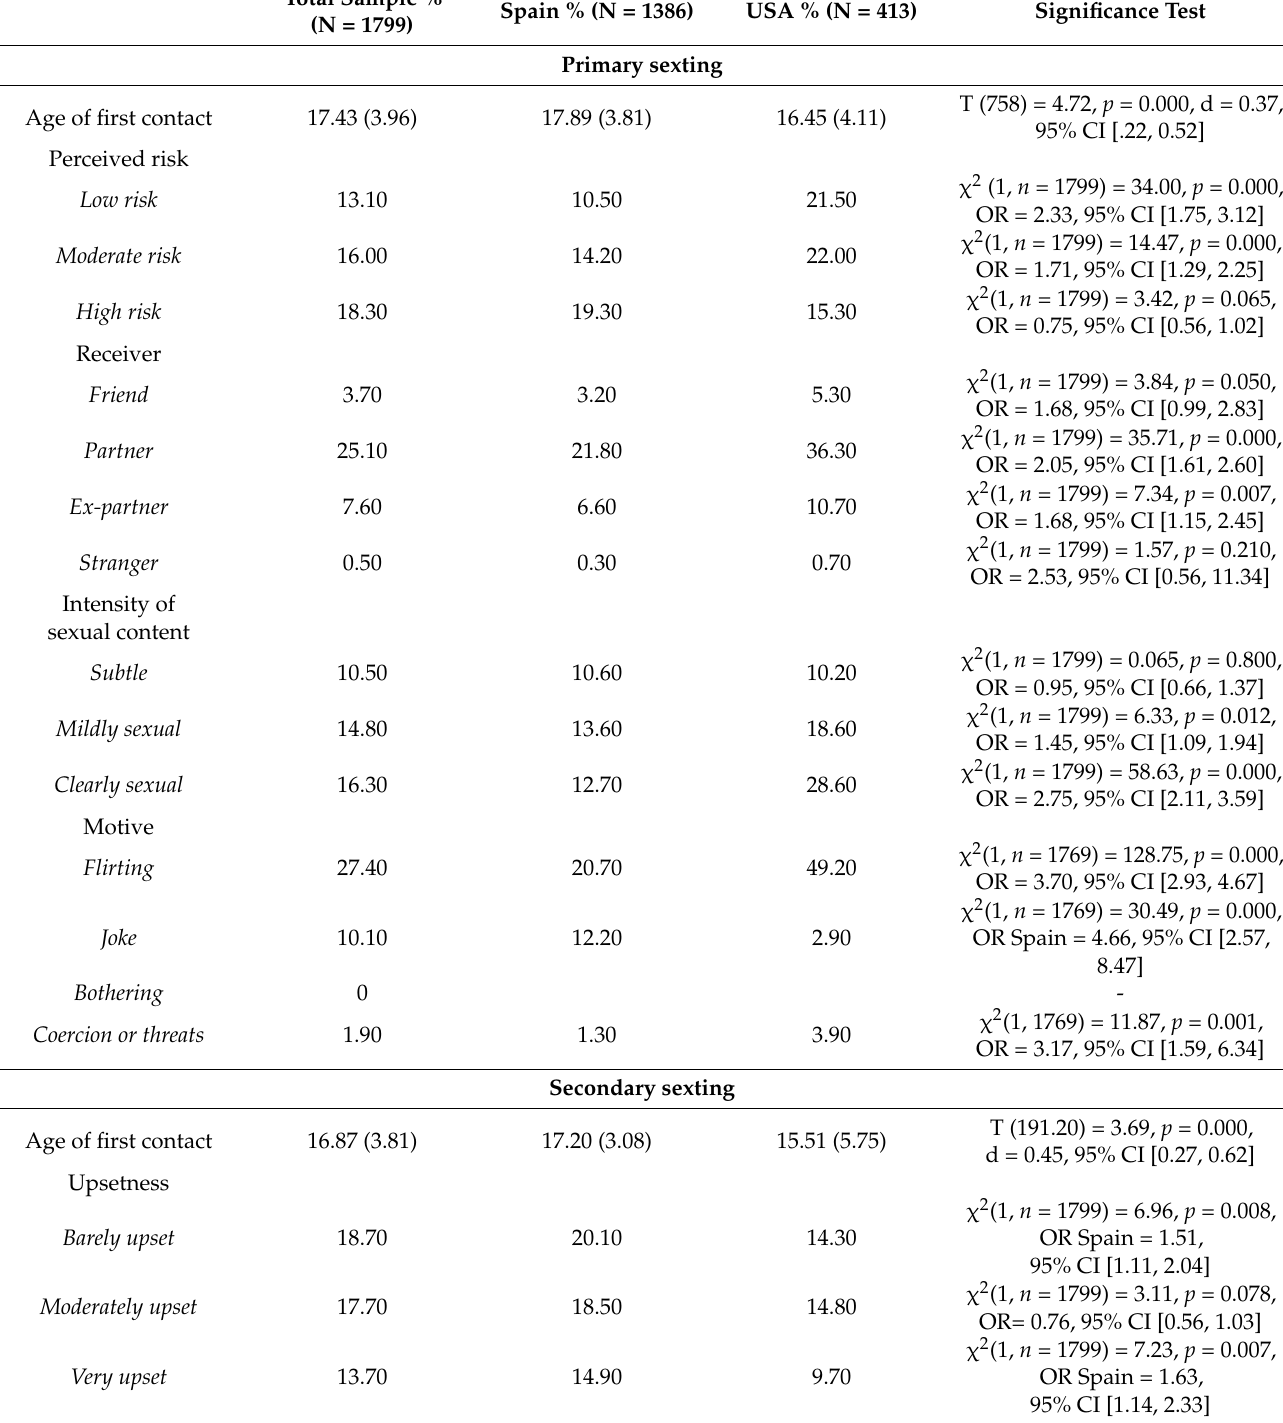
Table 4. Descriptive statistics for different sexting variables and